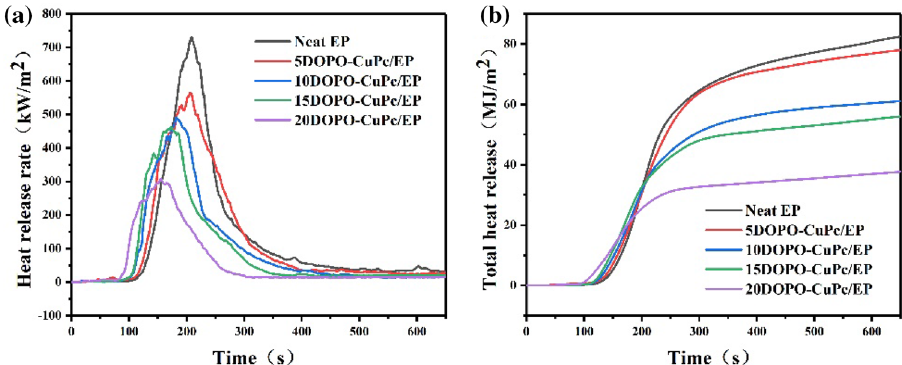
Figure 3. HRR ( a ) and THR ( b ) curves of epoxy thermosets.